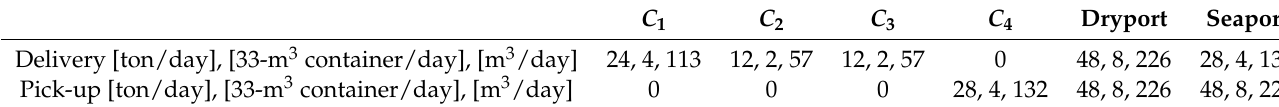
Table 2. Constant daily pick-up and delivery requests.